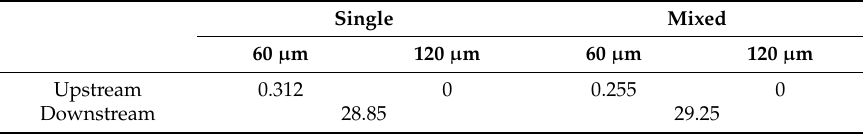
Table 10. Separation experiments for 60 and 120 µ m sand